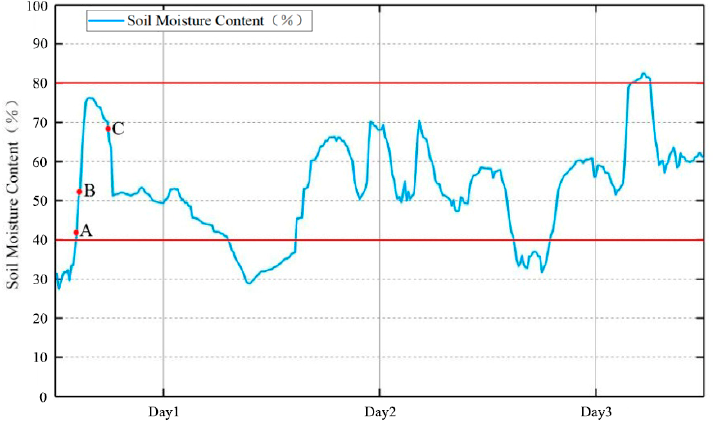
Figure 8. Measured and calculated data of soil moisture content used by the proposed system over 3 days.